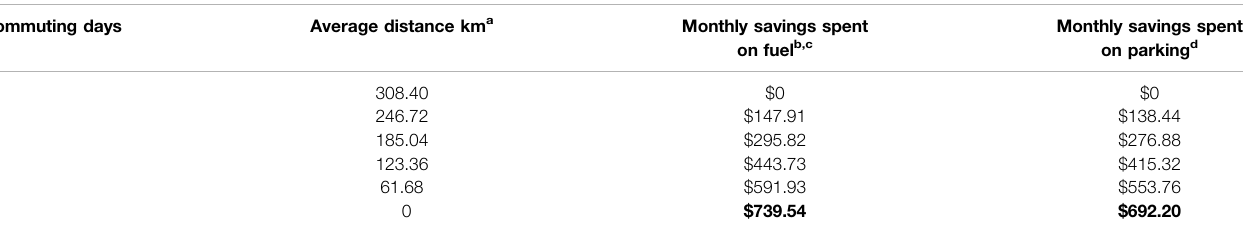
TABLE 2 | Commuting by car (Hong